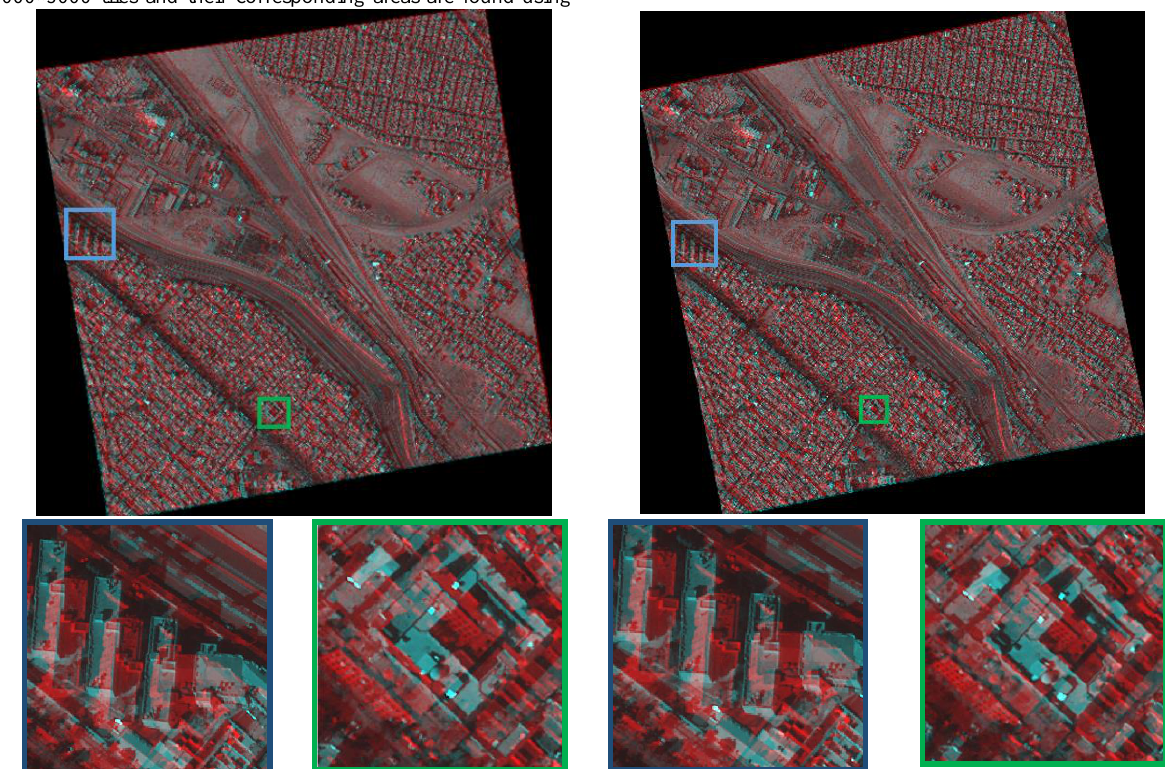
Figure 7. Stereo anaglyph of the generated epipolar images by fundamental matrix (left) and Morgan’s method (right) Figure 8 contains the computed disparity map for both epipolar resampling